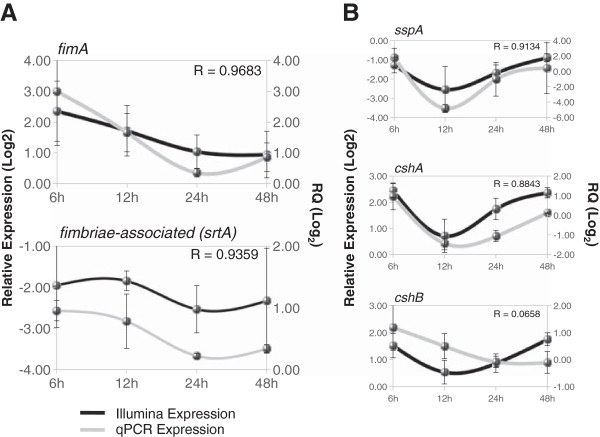
Gene expression comparison between Illumina sequencing and qPCR during biofilm formation. A - Genes associated to Type 2 Fimbriae assembly in Actinomyces naeslundii were analyzed and Pearson correlations calculated from expression values obtained by these two approaches. B – Adhesion genes from Streptococcus gordonii were also analyzed and their expression pattern was compared.